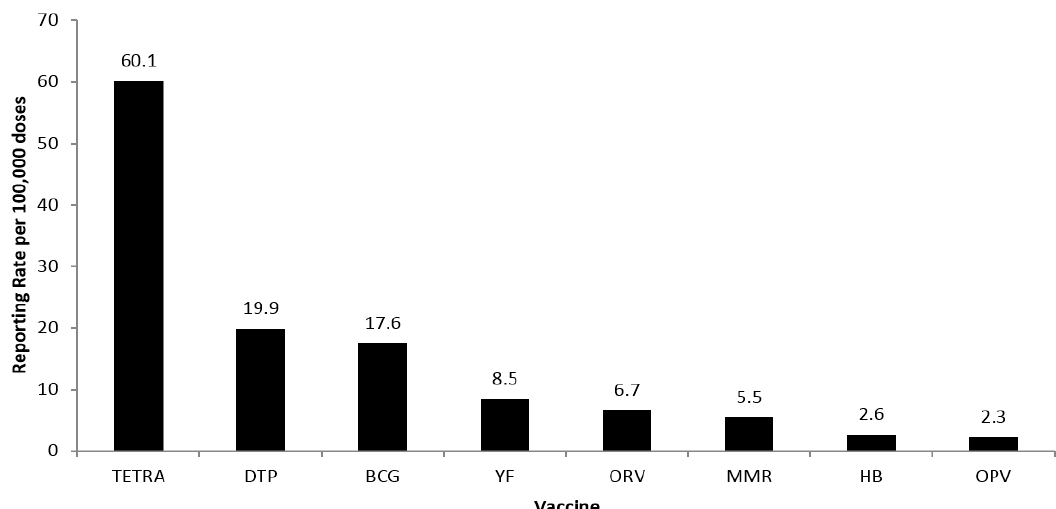
Figure 1. Estimated rate of AEFI per 100,000 doses in children younger than 10-years old, between 2005 and 2010 considering single and combined inoculations (TETRA: diphtheria, pertussis, tetanus, Haemophilus influenzae type b; DTP: diphtheria, tetanus, pertussis; BCG: Bacillus Calmette–Guerin; MMR: measles, mumps, rubella; HB: hepatitis B; YF: yellow fever).